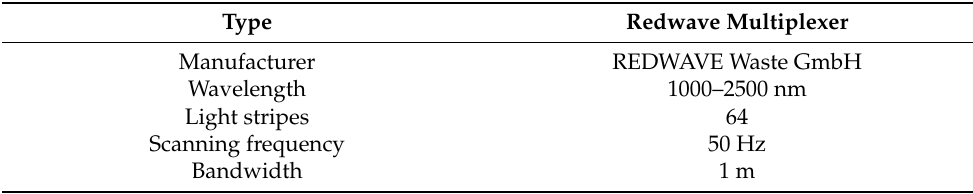
Table 16. Operating parameters of the assumed NIR (Near Infrared) sorter.